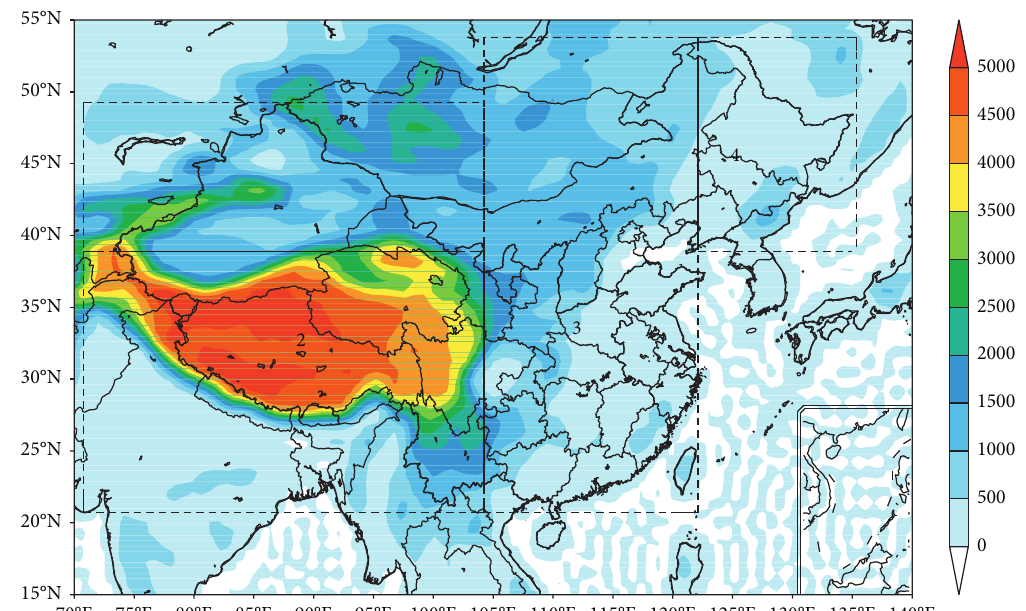
Figure 12: Topographic map of China (unit: m) and four climatic regions. Region 1 is 38 ° N–49 ° N, 70 ° E–104 ° E; region 2 is 25 ° N–40 ° N,